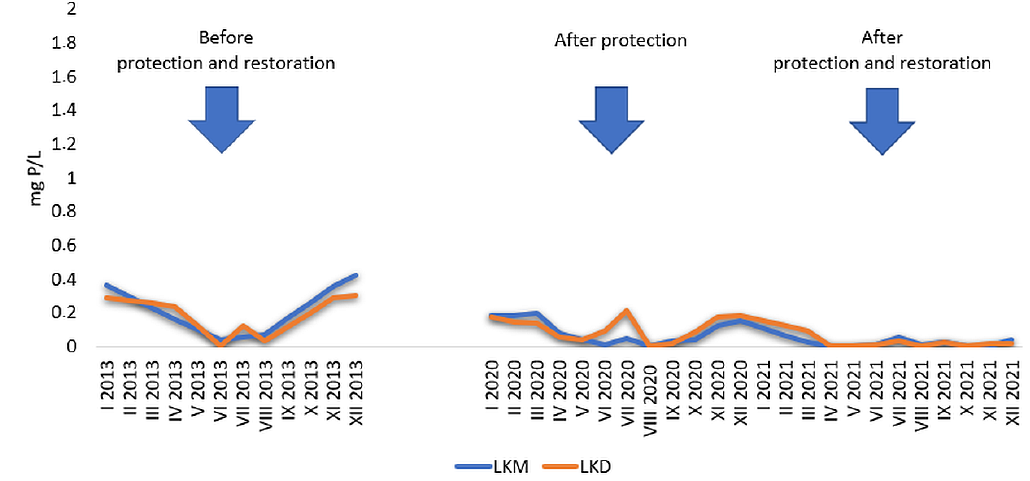
Figure 4. Changes in the content of mineral phosphorus (P min .) in the surface water layer of Klaszt- orne lakes in selected research years.